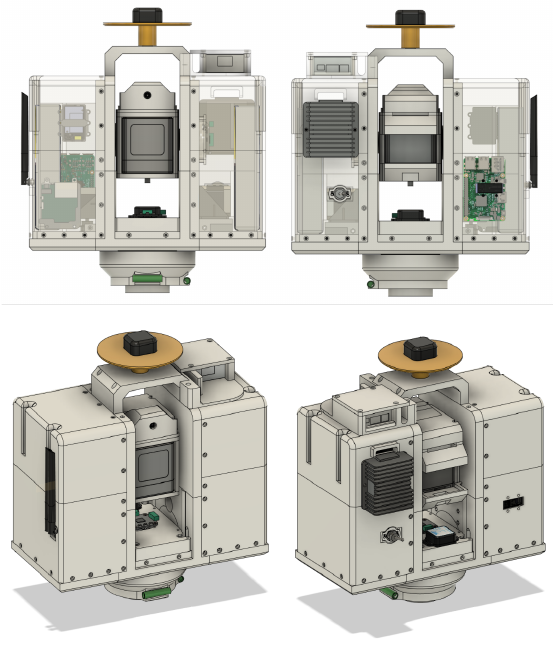
Figure 3. 3D CAD model of the developed TLS